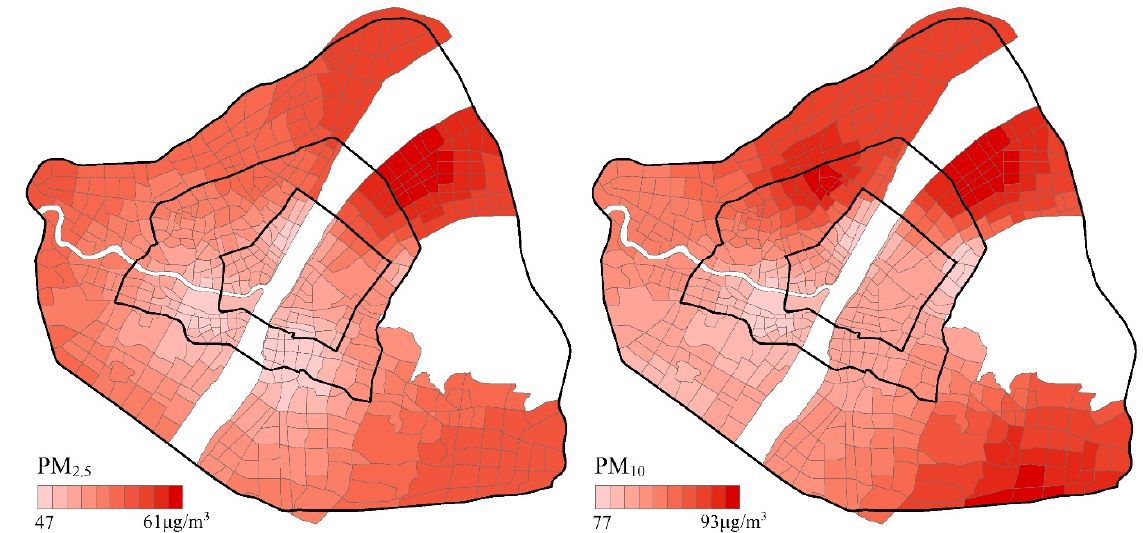
Figure 6. Maps of mean concentration of air pollutants during the study period. Table 1. Correlation between air pollution concentration, building density, and FAR.